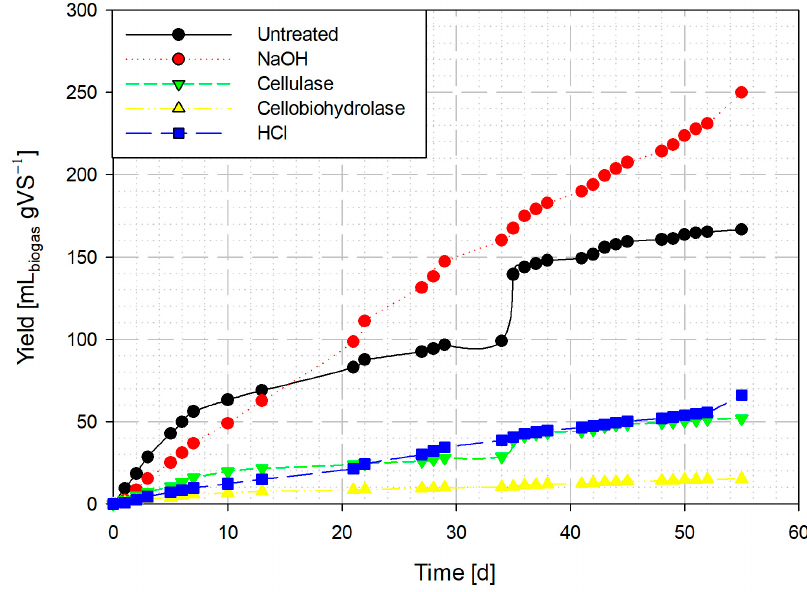
Figure 3. Biogas production yield in pretreated biomass of APRc at room temperature.